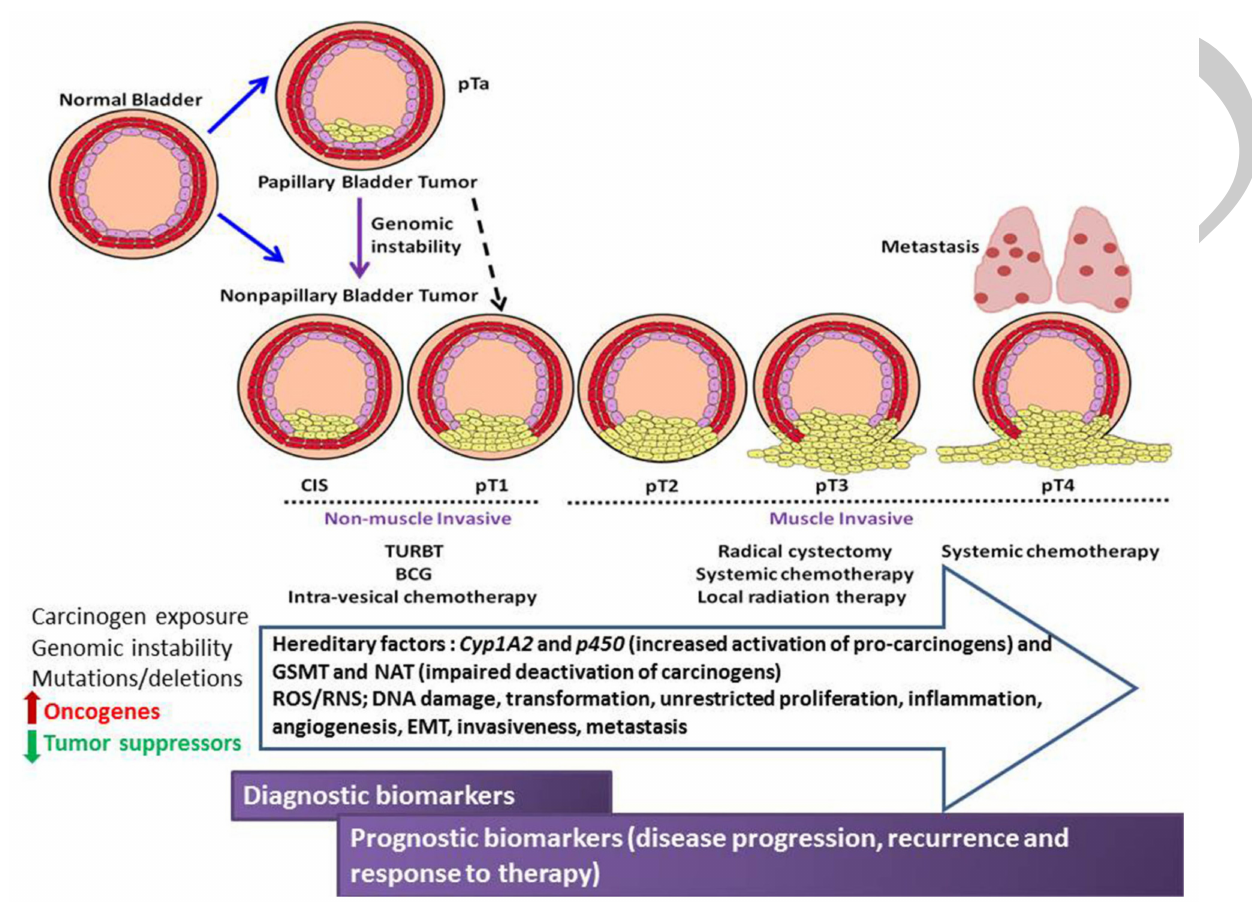
Figure 1. Schematic illustration of the pathological stages of urothelial cancer of the bladder, therapeutic intervention, environmental, genetic, and molecular influences of urothelial carcinogenesis, progression, and metastasis. Opportunities for diagnostic/prognostic biomarker discovery are shown compared to disease stage. (Adapted from© Bincy Anu John1 and Neveen Said, Insights from animal models of bladder cancer: recent advances, challenges, and opportunities, Oncotarget, 2017, Vol. 8, (No. 34) [12]). CIS—carcinoma in situ; TURBT—transurethral resection of bladder tumor;